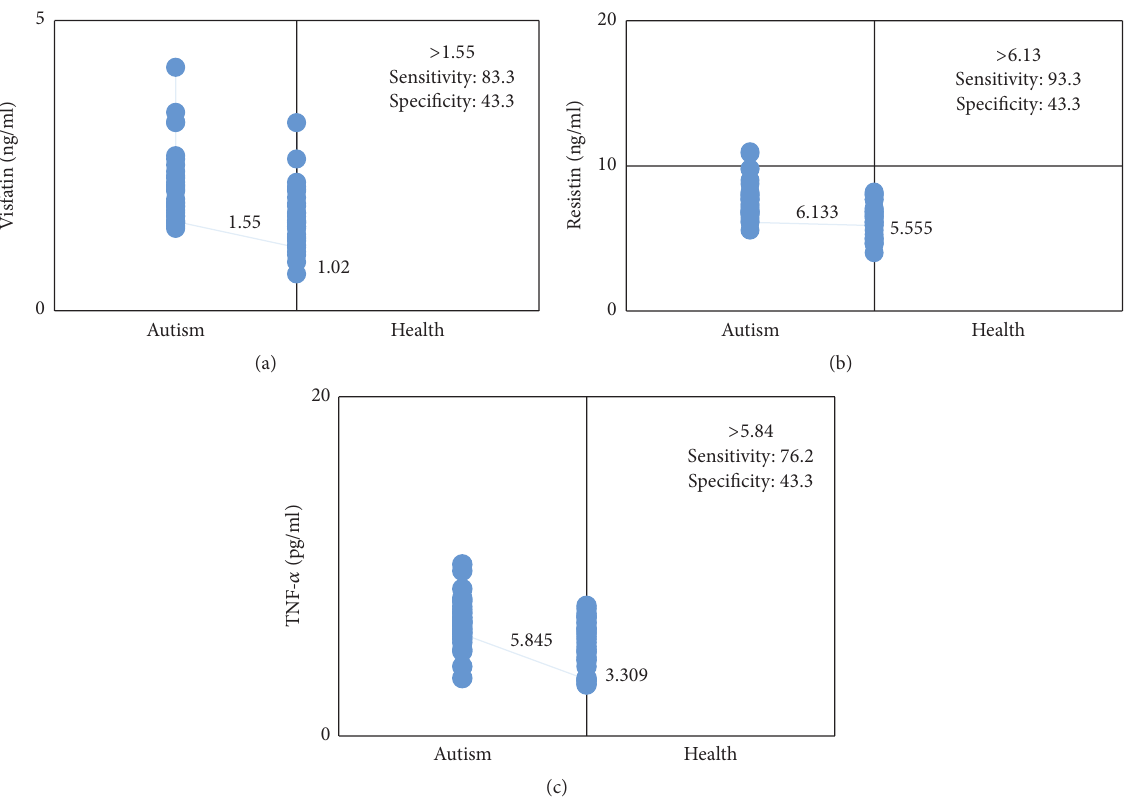
Rett syndrome [33, 34]. Rodrigues et al. reported low levels of resistin, high levels of leptin, and unaltered levels